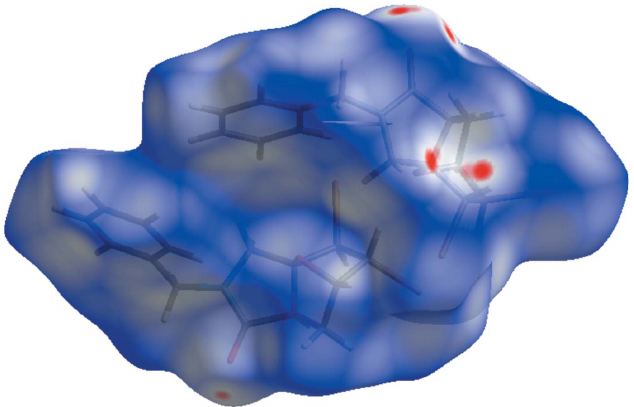
Figure 5 A view along the b axis of the intermolecular C—H (cid:2)(cid:2)(cid:2) O interactions in the title compound.